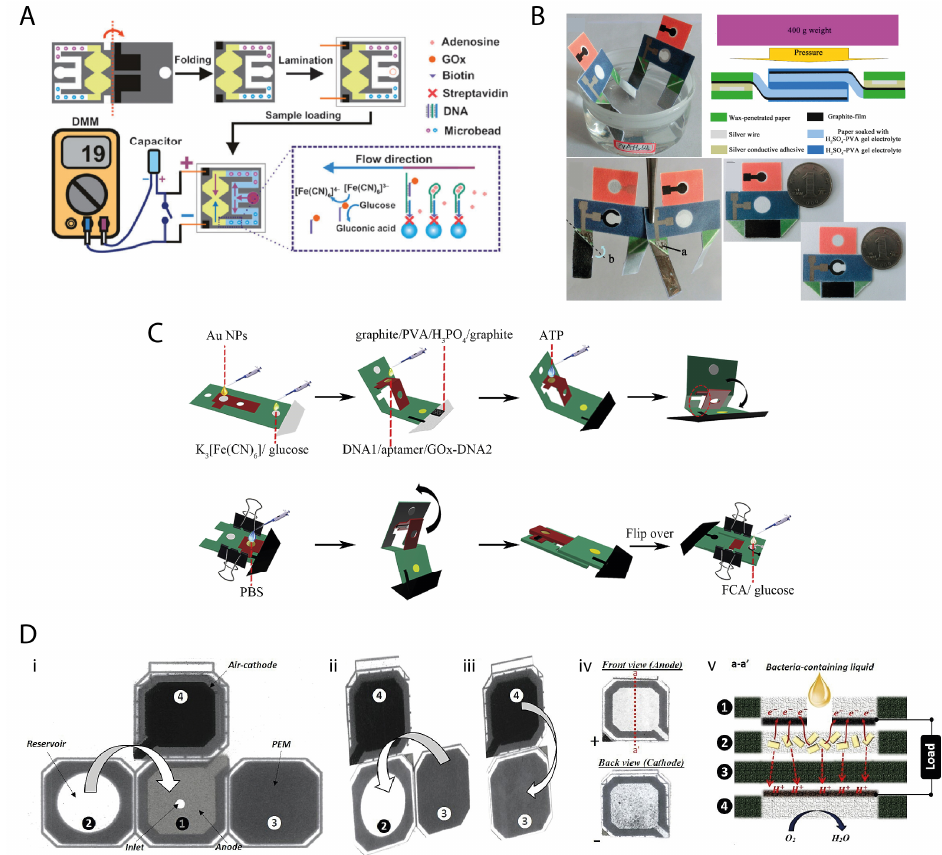
Figure 6. ( A ) Aptamer-based origami paper analytical device for electrochemical detection of adenosine. Reprinted with permission from [53], 2012 WILEY-VCH Verlag GmbH & Co; ( B ) photoelectrochemical lab-on-paper device based on an integrated paper supercapacitor and internal light source. Reprinted with permission from [54], 2013 American Chemical Society; ( C ) a self-powered origami paper analytical device with a pop-up structure for dual-mode electrochemical sensing of ATP assisted by glucose oxidase-triggered reaction. Reprinted with permission from [55], 2019 Elsevier; ( D ) power-on-paper: origami-inspired fabrication of 3D microbial fuel cells. Reprinted with permission from [85], 2017 Elsevier.